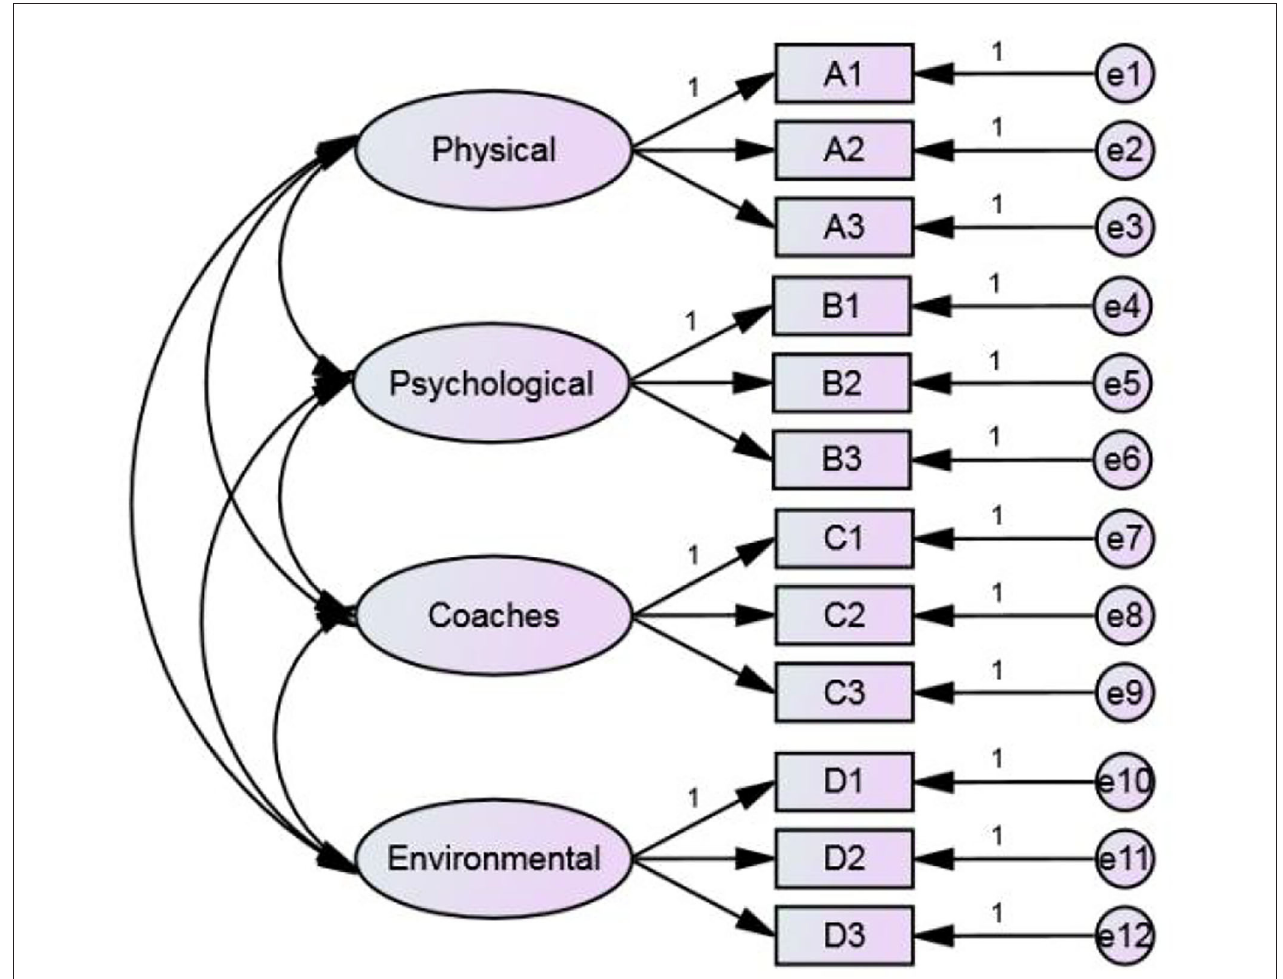
FIGURE 3 | Confirmatory factor analysis